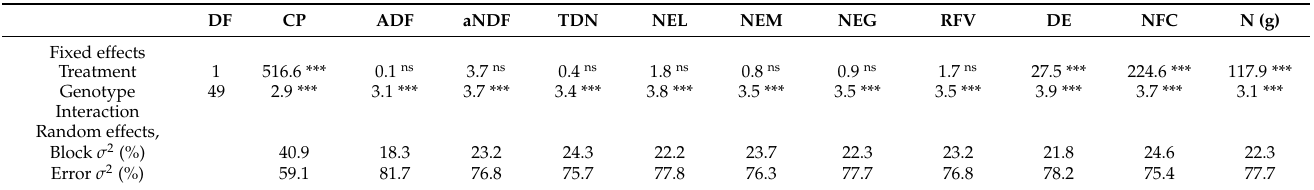
Table A4. Mixed-model ANOVA fixed-effects F-test statistics with significance levels and random effects variance components for treatment and genotype on nutritional value traits.